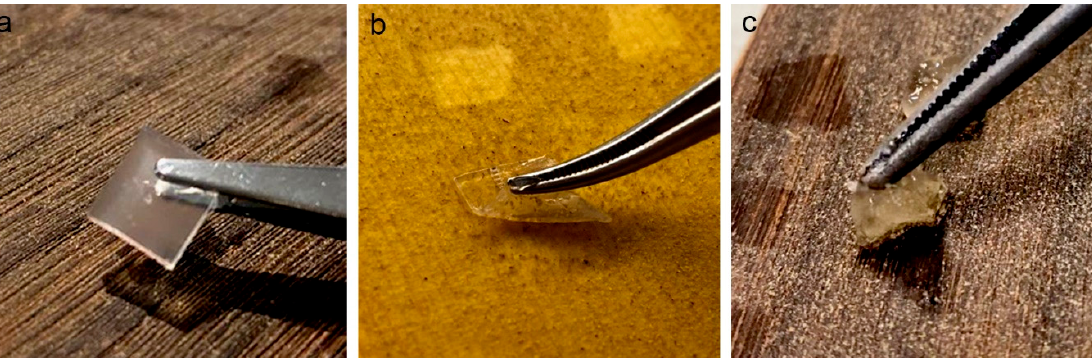
Figure 1. Images of application of Agar gel on soiled-EAM ( a ), CA gel on soiled-WM ( b ), and KGB gel on soiled-EAM ( c ).